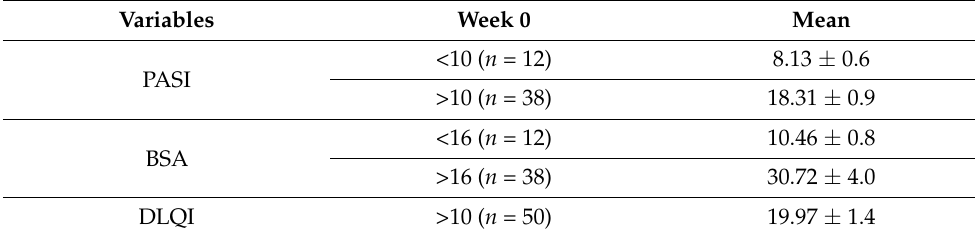
Table 3. Levels of PASI, BSA and DLQI indicators before the